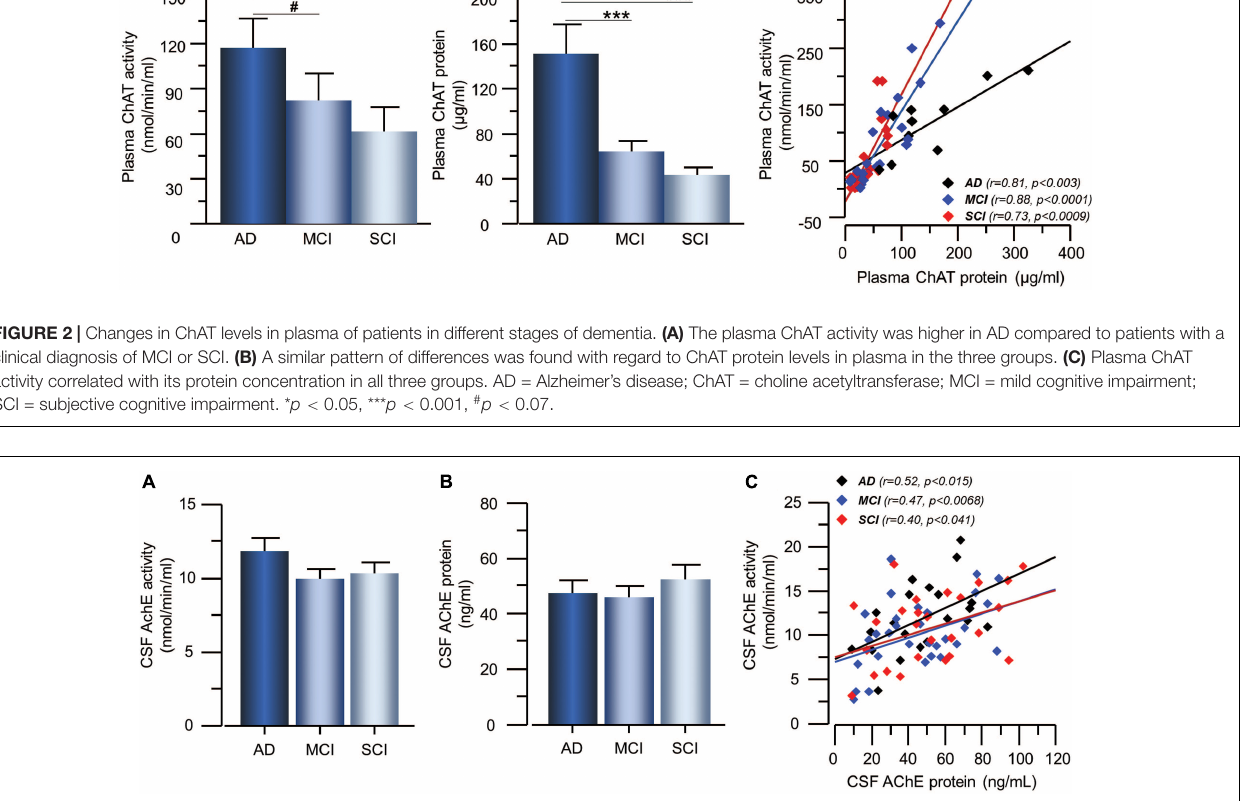
FIGURE 3 | Activity and protein levels of AChE in CSF of the patients. (A) The CSF AChE activity did not differ between patients with the clinical diagnoses of AD, MCI, or SCI. (B) Similarly, the CSF protein levels of AChE did not differ between the groups. (C) The overall AChE activity correlated with its protein levels in the CSF. AChE = acetylcholinesterase; AD = Alzheimer’s disease; CSF = cerebrospinal fluid; MCI = mild cognitive impairment; SCI = subjective cognitive impairment.